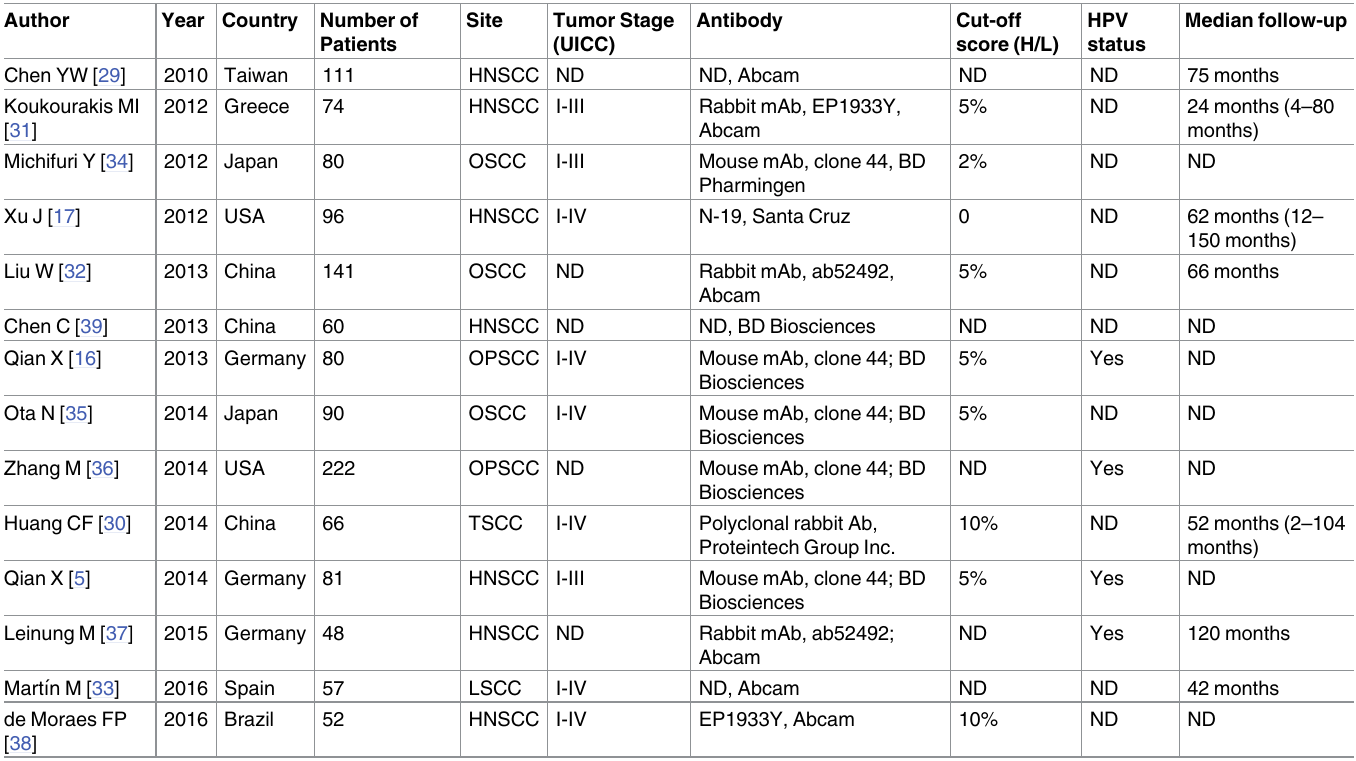
Table 1. Main characteristics and results of the eligible studies.